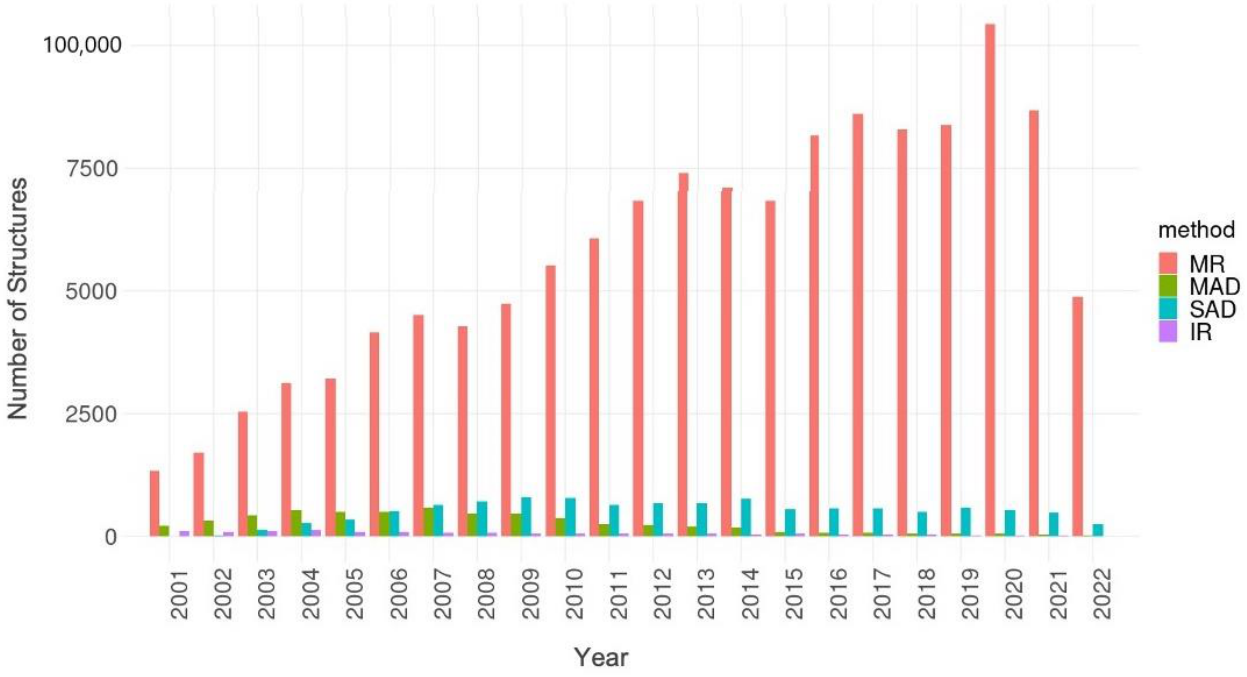
Figure 3. PDB MX structure phasing method trends vs. year of structure release from 2001 – 2021 (MR: molecular replacement; MAD: multi-wavelength anomalous dispersion; SAD: single-wavelength anomalous dispersion; IR: isomorphous replacement).